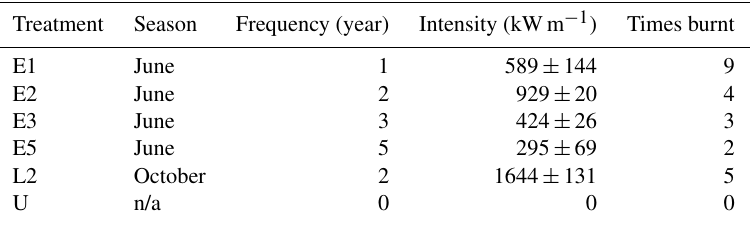
Table 1. Fire regime characteristics of the Territory Wildlife Park experimental site. Data are for the period 2004–2013. Fire intensity values are the mean and standard error over the course of the